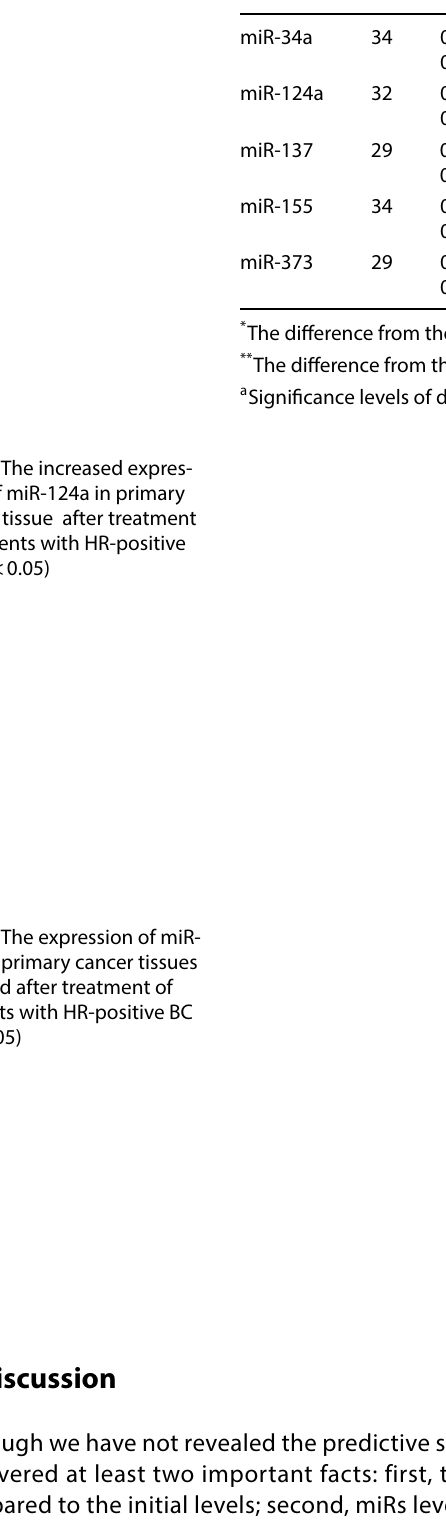
Table 3 The levels of miRNA from primary tumor, after NACT and adjacent non- tumor tissues